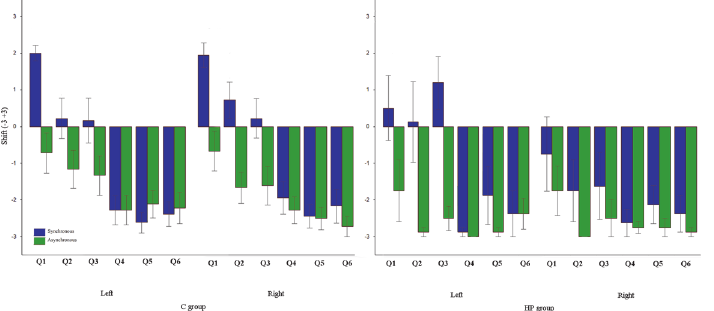
Fig 4. Graphic representation of subjective rating analysis on the two groups. Error bars represent standard